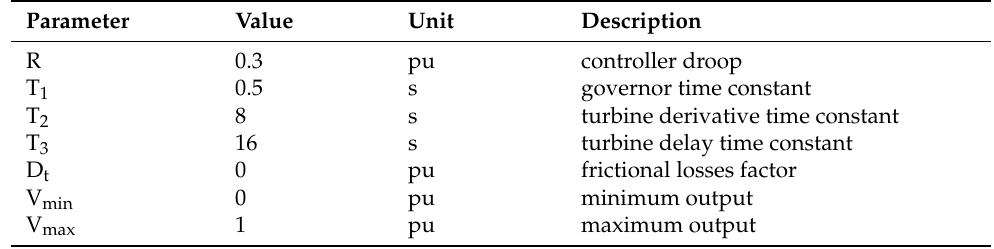
Table A3. Parameters set for the turbine/governor